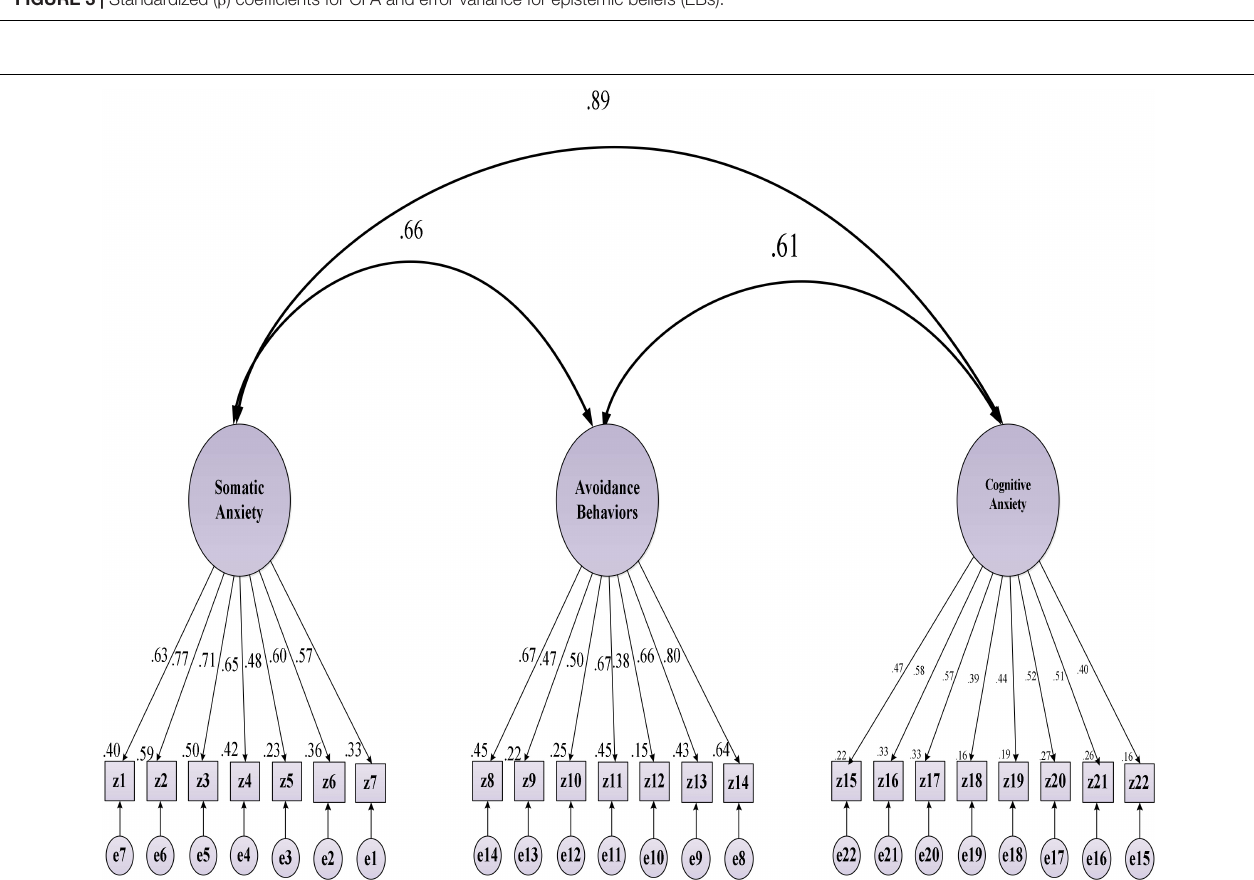
FIGURE 4 | Standardized ( β ) coefficients for CFA and error variance for second language writing anxiety (L2WA).